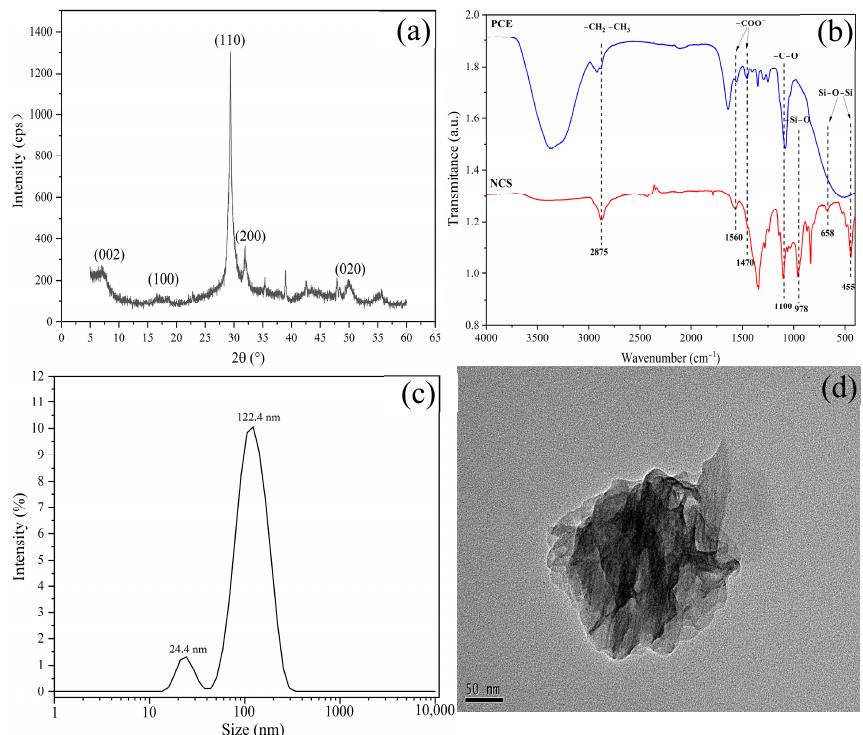
Figure 2. Characterization of NCS: ( a ) XRD pattern, ( b ) FT-IR spectra: blue line represents PCE, red line represents NCS, ( c ) particles size distribution of NCS, ( d ) morphology of NCS.